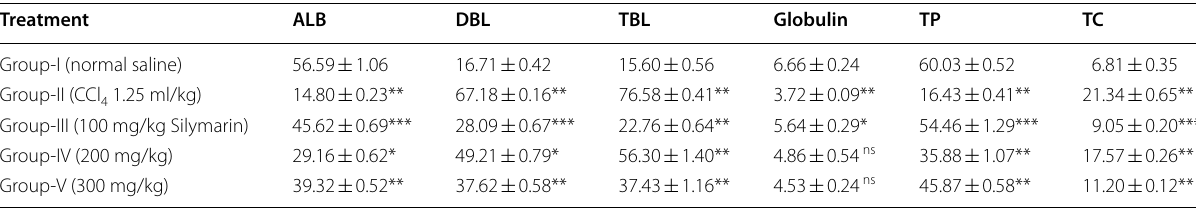
-induced hepatotoxic rats 4